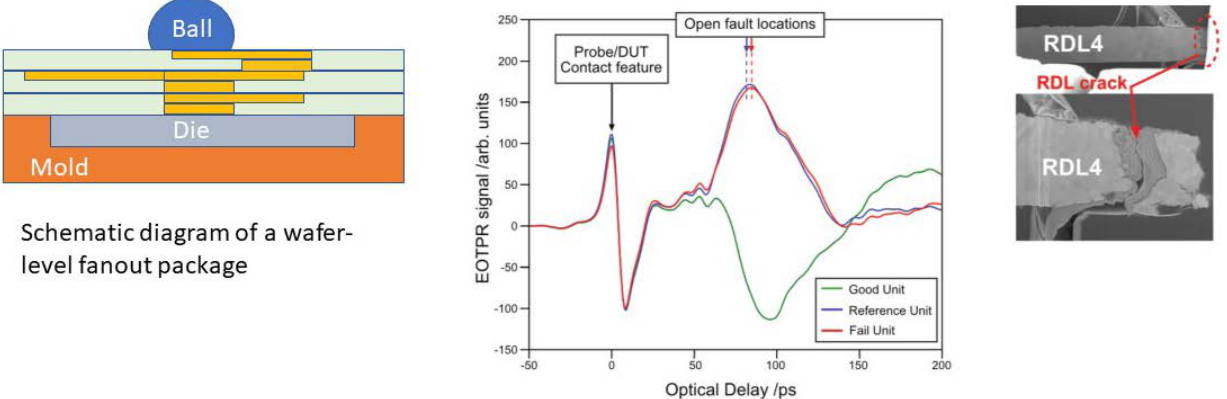
Figure 7. Detection of failure with EOTPR (green = good device, red = failed unit), including the ability of EOTPR to determine the exact position of faults around contacts, confirmed by physical fault analysis (photo).